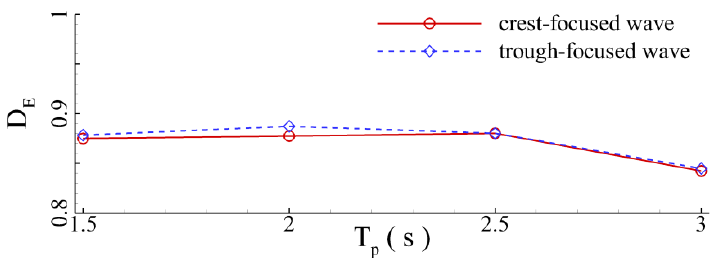
Figure 32. Wave energy dissipation rate versus the peak wave period.